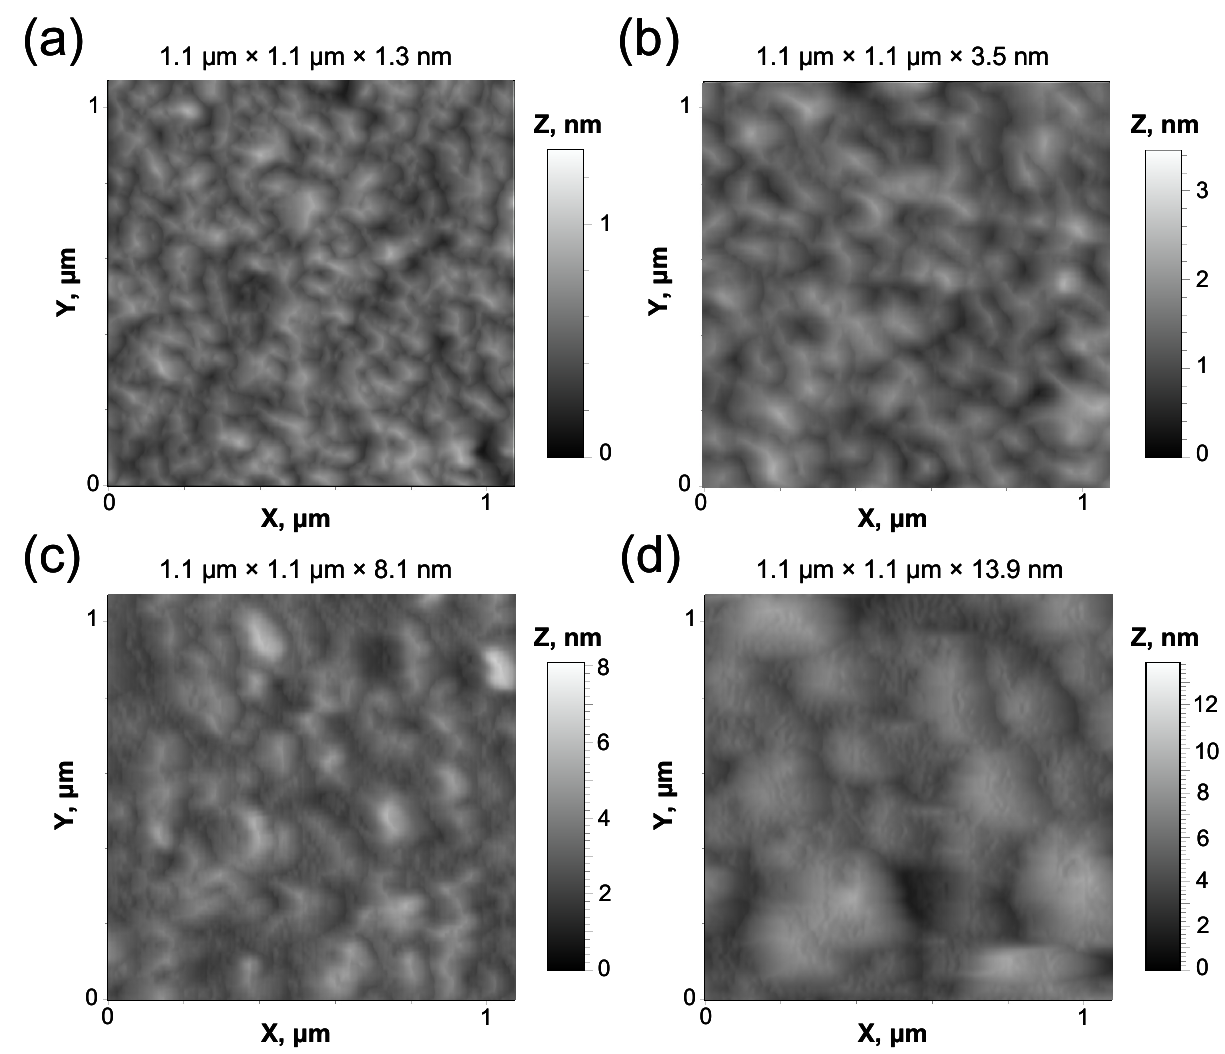
Figure 1. AFM surface topography of pristine graphene ( a ), N35 ( b ), N75 ( c ), and N110 ( d ).